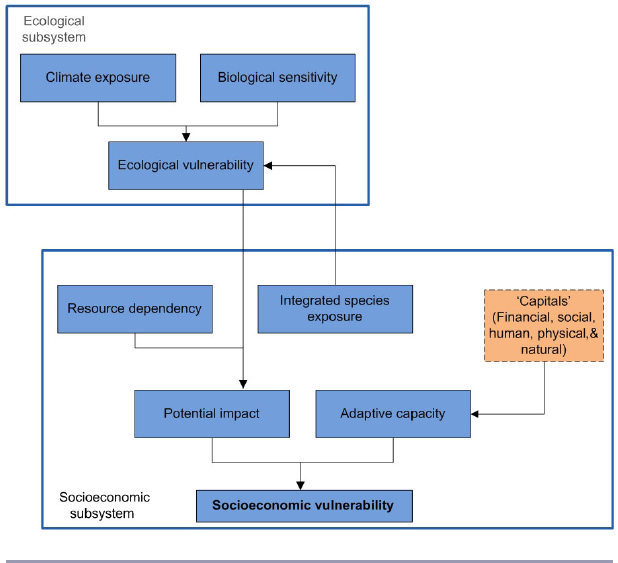
Fig. 2 . Framework for the calculation of socioeconomic vulnerability (and adaptive capacity) undertaken for each case study community, modified from Marshall et al.